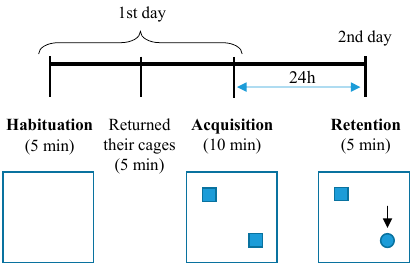
Figure 1. Schematic representation of novel object recognition assay. Following habituation trial in the empty boxes for 5 min, mice were allowed to explore an identical pair of objects placed in the boxes where two objects, one familiar and one novel, were placed. The time that mice spent exploring the two